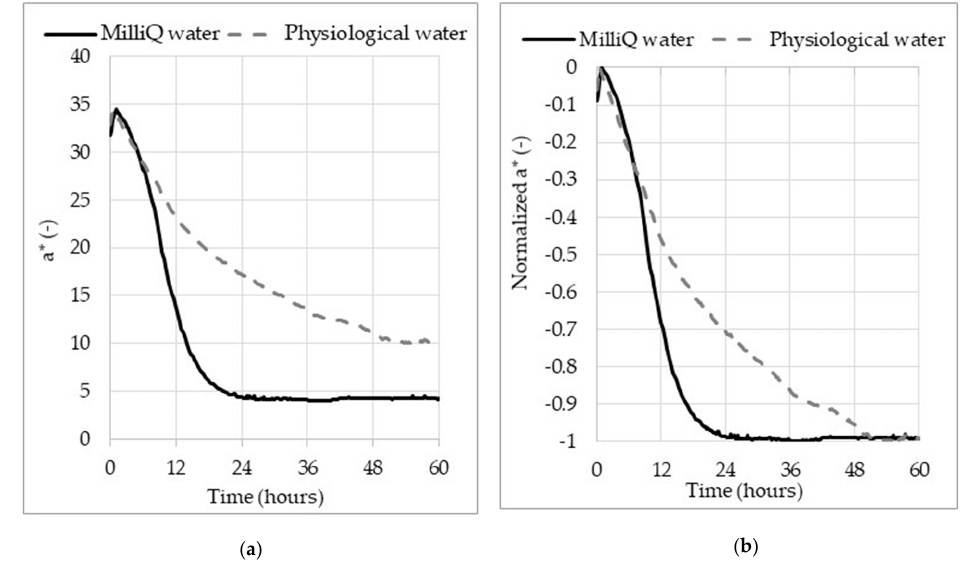
Figure 2. Monitoring of the color change (a*) as a function of time of ( a ) a rib steak juice (50 mL of centrifuged juice, filtered and 1 / 5 diluted) at 20 ◦ C according to the type of water (milliQ water, black solid line, or physiological water, grey dashed line) used to dilute the meat juice as a function of time and ( b ) the same data in normalized values, using Equation (1).